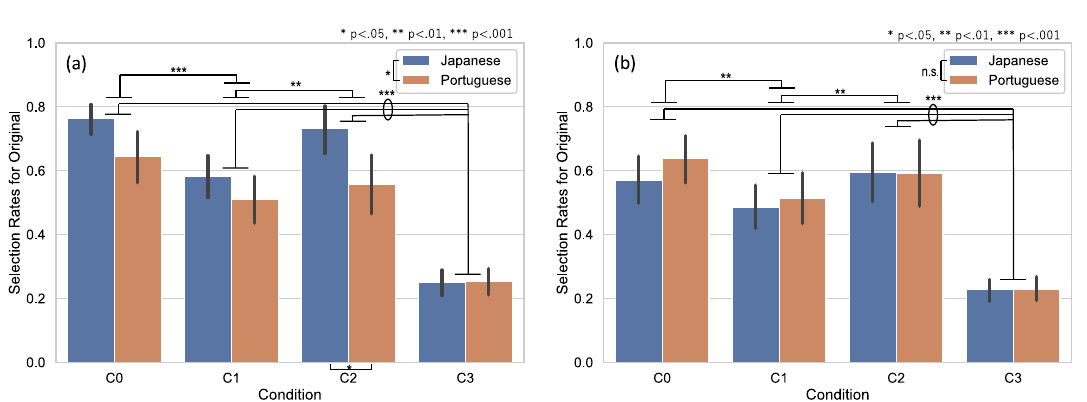
Figure 6. Average selection rates for the original images (0 degree) in different conditions. ( a ) The average selection rates measured in the main experiment reiterated from Fig. 4. ( b ) The average selection rates measured in the replication experiment reiterated from Fig. 5. Bars represent 95% confidence intervals. Asterisks indicate a significant difference; * p < 0.05, ** p < 0.01, *** p <